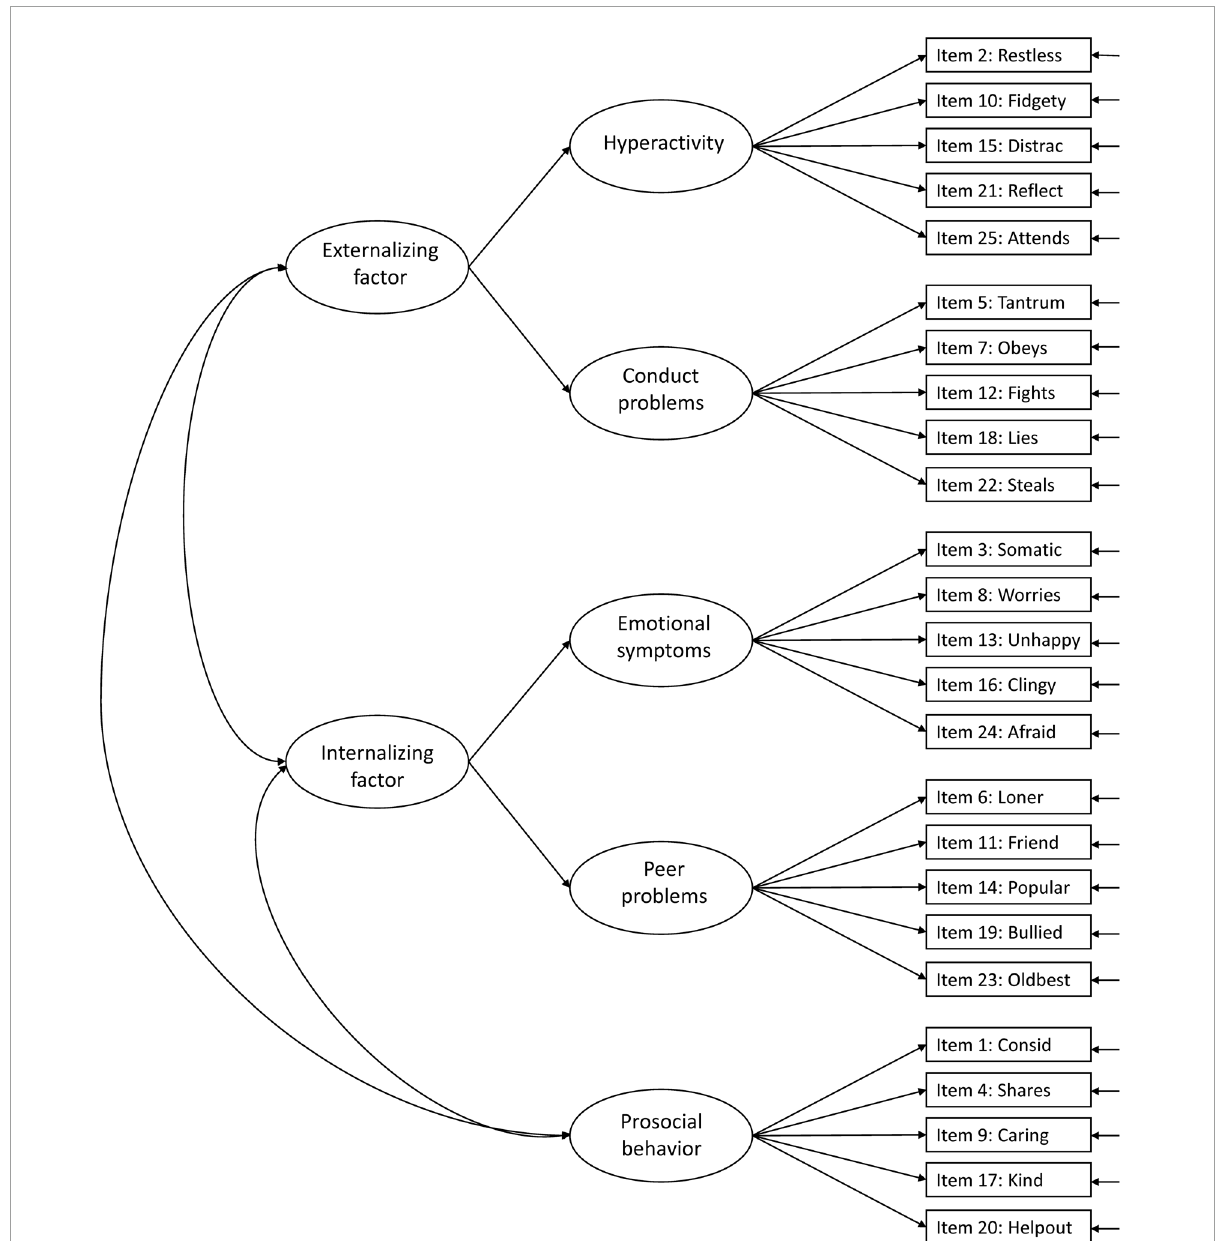
FIGURE2 Second-order model with internalizing and externalizing as second-order factors from the original five-factor structure (Model